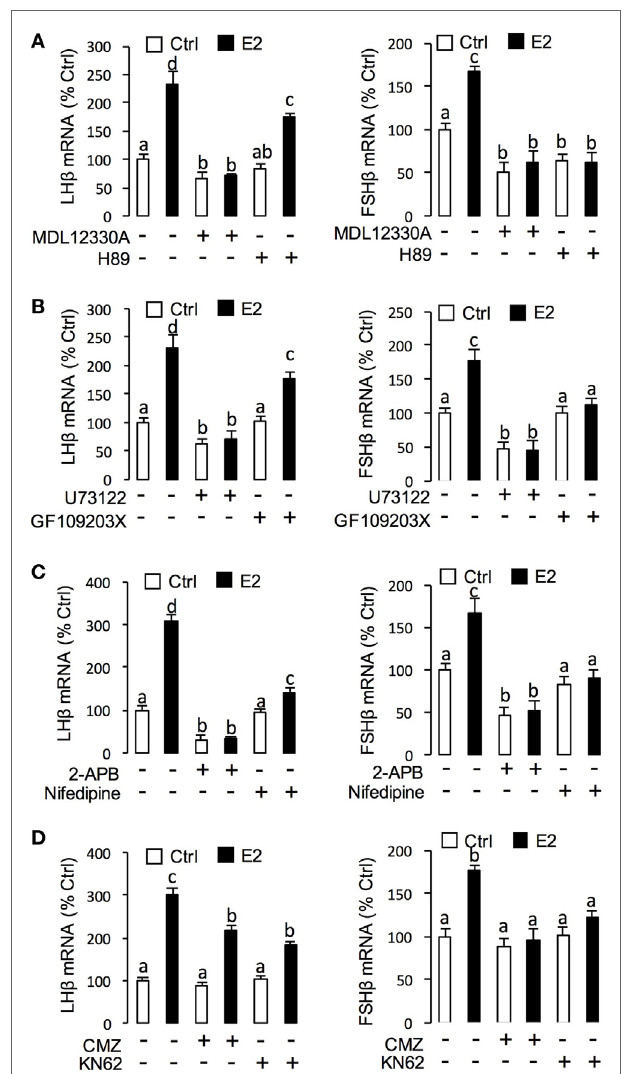
FigUre 7 | Signal transduction of E2-induced luteinizing hormone (LH) β and follicle-stimulating hormone (FSH) β mRNA expression in grass carp pituitary cells. (a) Effects of 24-h co-treatment with the adenylyl cyclase inhibitor MDL12330A (20 µM) or protein kinase A inhibitor (20 µM) on E2 (10 nM)- induced LH β and FSH β mRNA expression. (B) Effects of 24-h co-treatment with the phospholipase C inhibitor U73122 (10 µM) or protein kinase C inhibitor GF109203X (20 µM) on E2 (10 nM)-induced LH β and FSH β mRNA expression in carp pituitary cells. (c) Effects of 24-h co-treatment with inositol 1,4,5-triphosphate receptor blocker 2-APB (100 µM) or VSCC blocker Nifedipine (10 µM) on E2 (10 nM)-induced LH β and FSH β mRNA expression. (D) Effects of 24-h co-treatment with calmodulin antagonist calmidazolium (1 µM) or CaM-dependent protein kinase II inactivator KN62 (10 µM), respectively, on E2 (10 nM)-induced LH β and FSH β mRNA expression in grass carp pituitary cells.